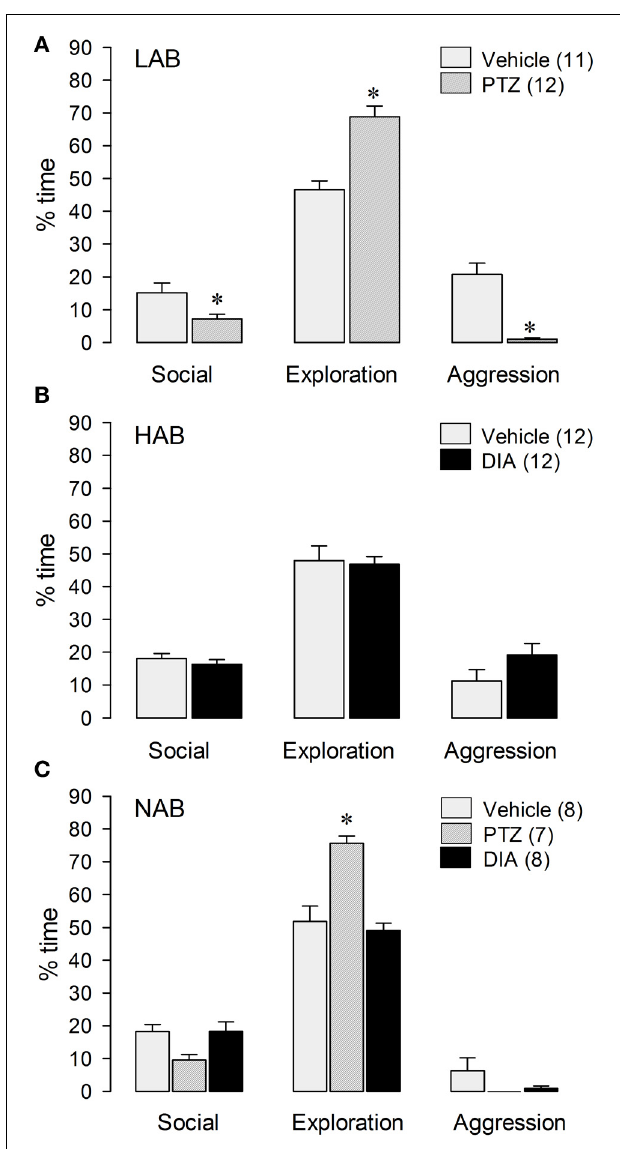
FIGURE 3 | Behavior of LAB (A), HAB (B), and NAB (C) rats during the RI test. Pentylenetetrazol (PTZ, 25mg/kg) and Diazepam (DIA, 2mg/kg) were applied ip 30min before testing. Social investigation, cage exploration, and aggressive behavior are calculated as percentage of total time (10min). Numbers in parentheses indicate group size. Date are means + s.e.m., ∗ p < 0 . 05 vs. vehicle. One-Way-ANOVA followed by post-hoc test (Bonferroni) and student’s t -test,